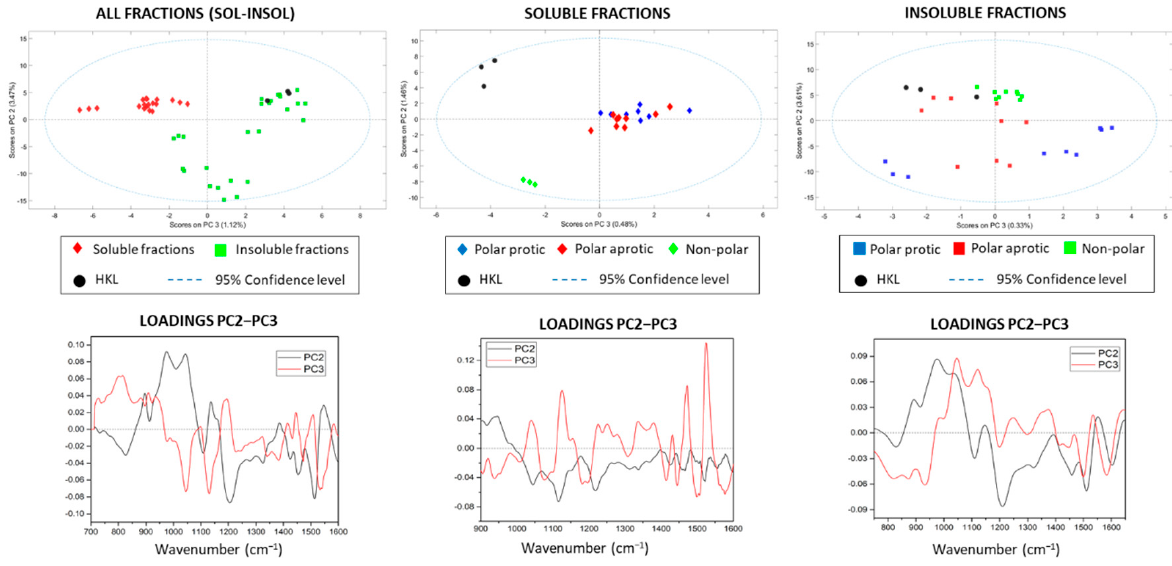
Figure 3. FTIR analysis, scores, and loadings of all samples, and in the soluble and insoluble frac- tions.